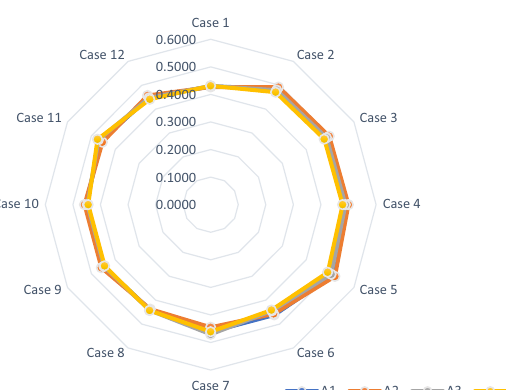
Fig. 6 Results of sensitivity analysis